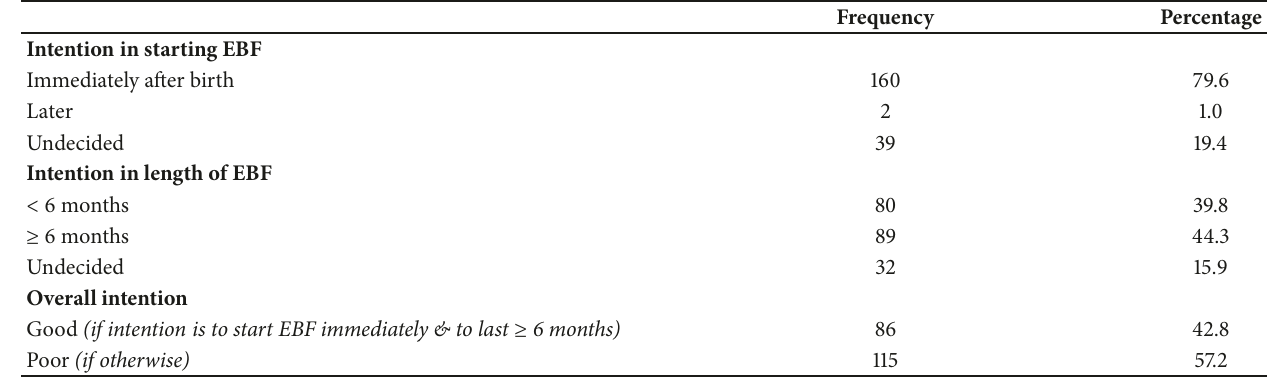
Table 5: Intention to practice exclusive breastfeeding (n =